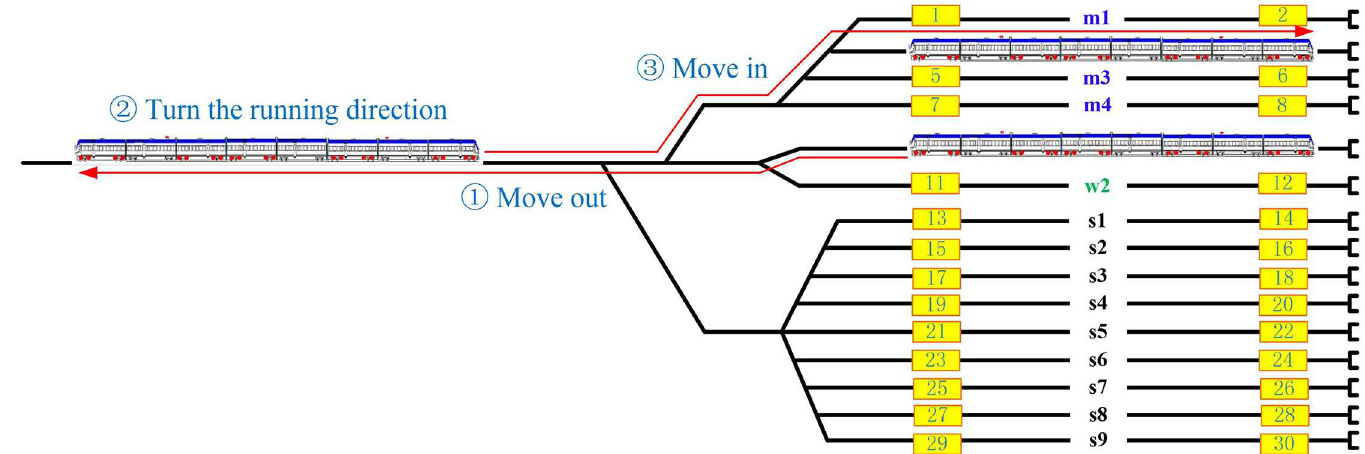
Fig 4. A shunting movement from track w1 to track